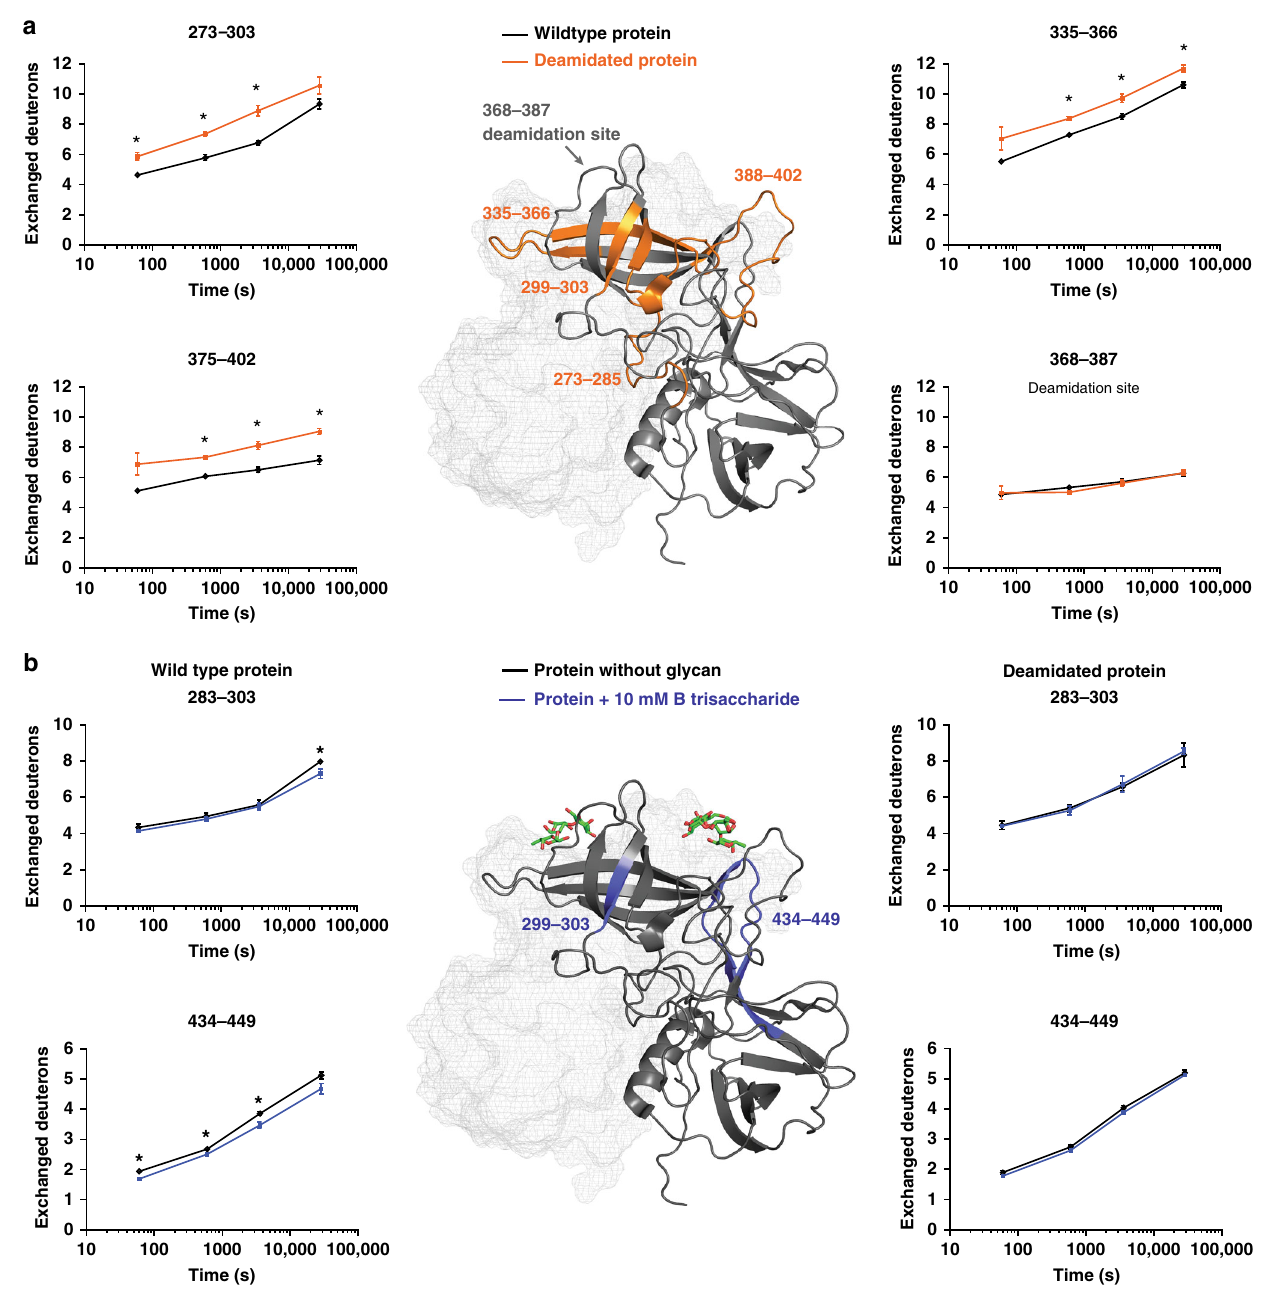
Fig. 6 Hydrogen/deuterium exchange (HDX) MS experiments reveal changes in protein dynamics upon deamidation. a Deuterium uptake differences of the wild-type and deamidated GII.4 Saga P-dimer mapped to the crystal structure (pdb: 4 × 06). b Deuterium uptake differences of the wild-type and deamidated P-dimer in presence and absence of 10 mM B trisaccharide. Signi fi cant (* p < 0.01, Student ’ s T -test) protection is detected in peptides covering the canonical binding site (G443, Y444), whereas this effect is absent in the deamidated P-dimer. The reduction in HDX observed in peptide 283 – 303 can be narrowed down to residues Y299-L303, as a peptide covering residues I283-N298 shows no differences in exchange at the 8 h time point (see Supplementary Data 1 – 4 for details). All measurements were performed in triplicate, and error bars indicate the standard deviation. A complete collection of deuterium uptake plots is found in in Supplementary Data 1 –